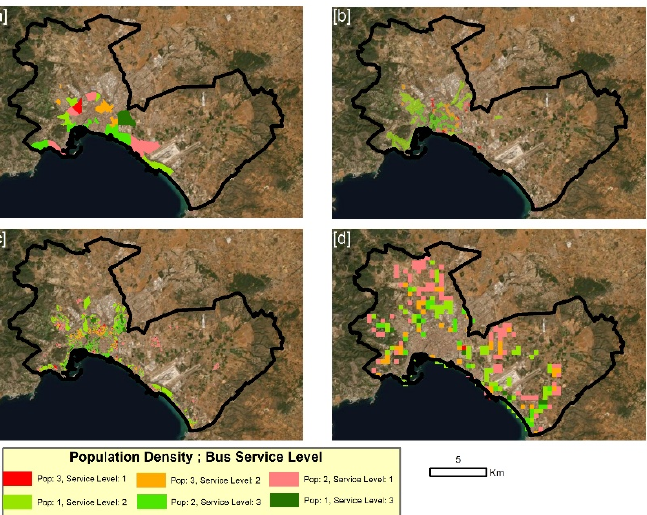
Figure 7. Imbalances between service level and population: ( a ) Neighbourhoods; ( b ) Census sections; ( c ) Cadastral blocks; and ( d ) 400 × 400 m mesh.